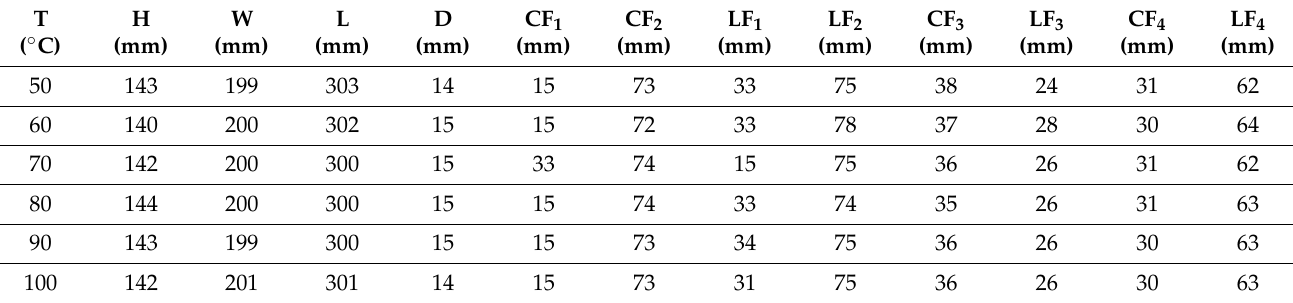
Table 1. Dimensions of the ceramic block before drying at different temperatures